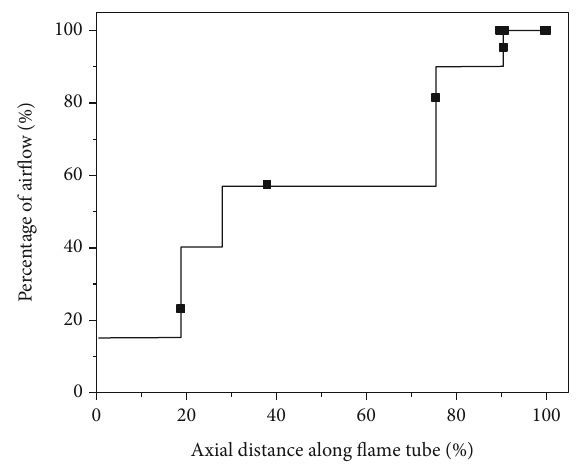
Figure 6: Air mass fl ow distribution along the axial direction.